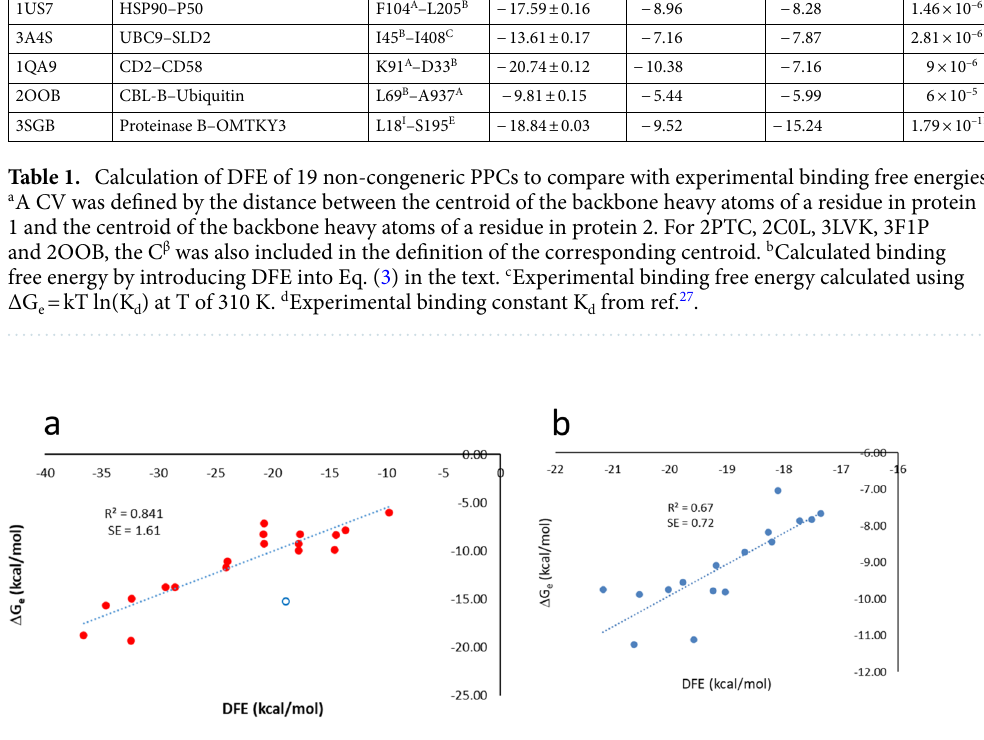
Figure 2. Correlation plots between calculated DFE and experimental binding free energies ∆G e . ( a ) Correlation plot for 19 PPCs. The open circle is an outlier (corresponding to complex 3SGB in Table 1). The indicated R 2 and SE (Standard Error) correspond to the Least-Square-Fitting after excluding the outlier. ( b ) Correlation plot for PLCs for target